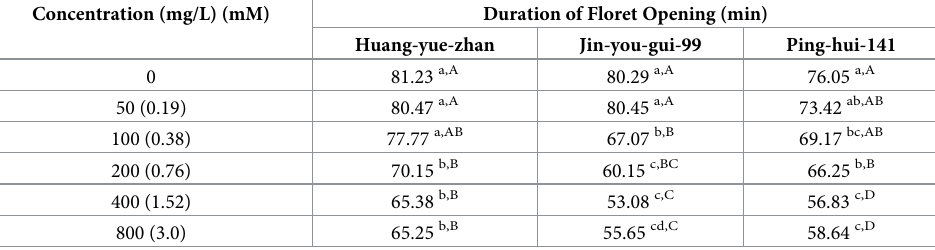
Table 3. ABA regulation of the duration of floret opening in fertile rice.